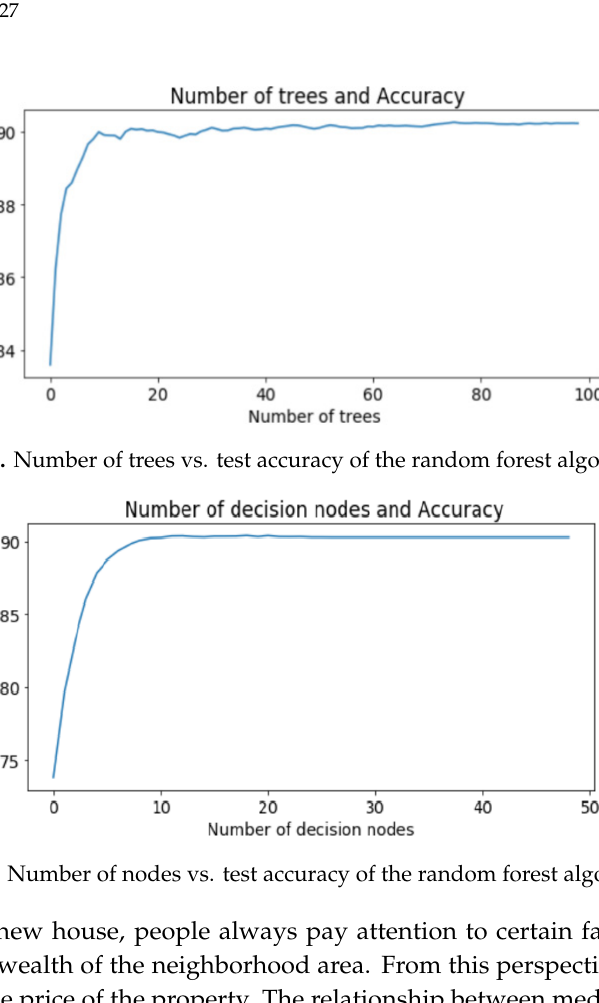
Figure 7. Number of nodes vs . test accuracy of the random forest algorithm.